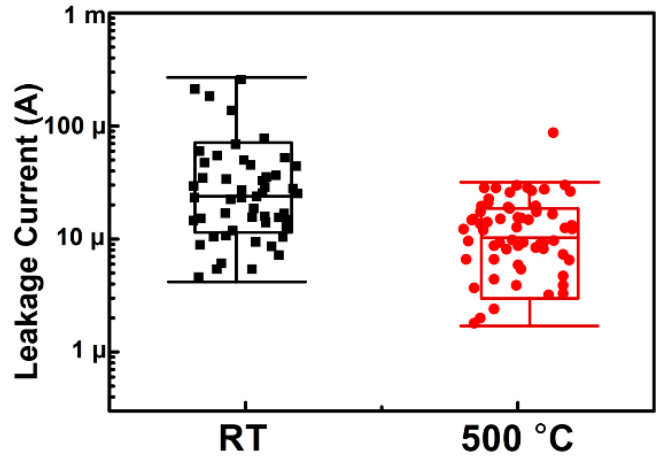
Figure 8. JBS block leakage current at 1200 V.